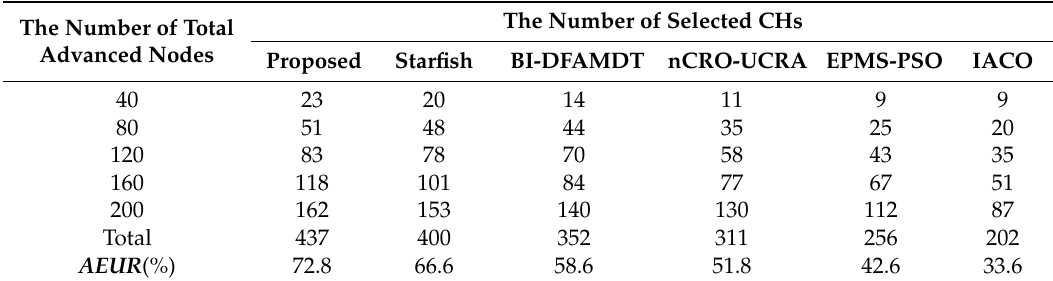
Table 8. Advanced energy usage results for scenario